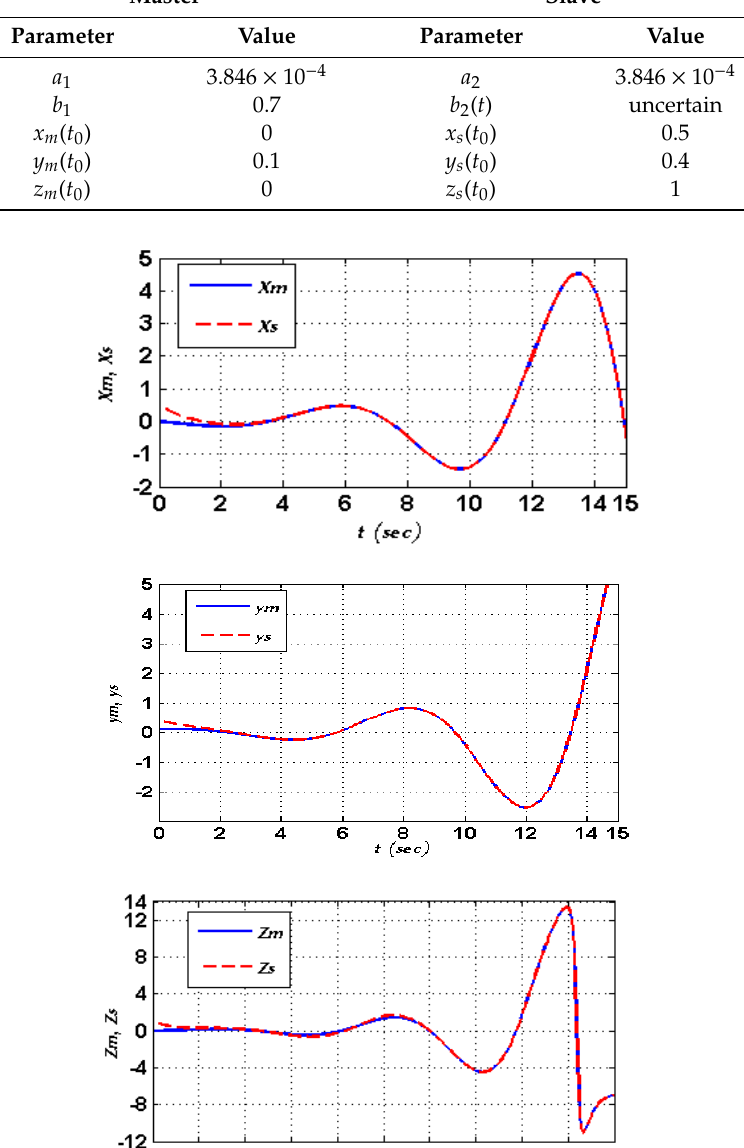
Figure 5 . Synchronization errors.